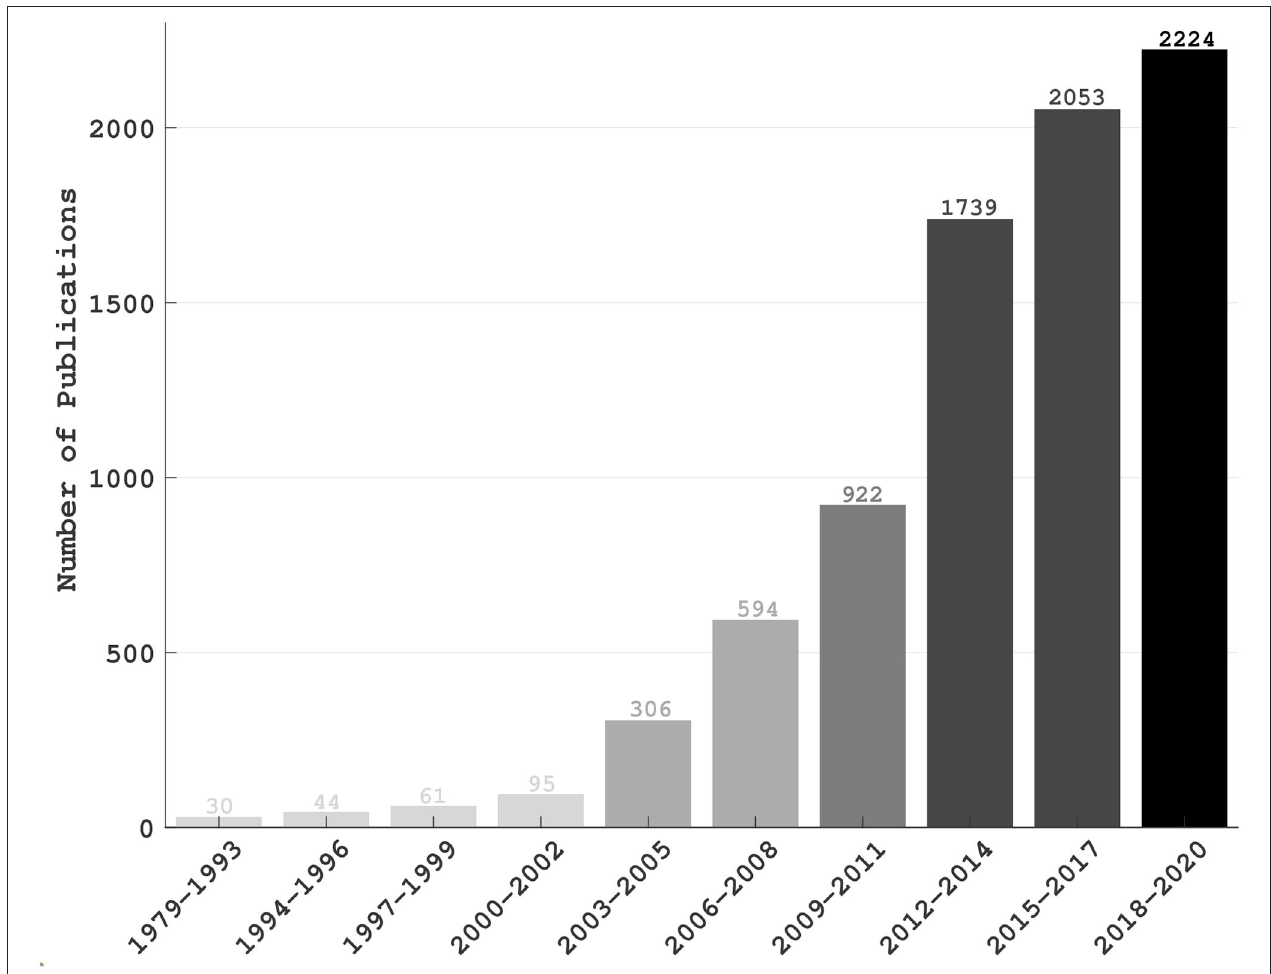
FIGURE 1 | The number of publications over the years: The statistics was based on a search on PubMed in which “brain computer interface” was the search keyword. The publications those were listed until 4th December 2020 have been accounted only. A significant increase in the number of publications in this decade as compared to the last decade implicates the engagement of a greater community in this field and, thus the importance of BCI technology.